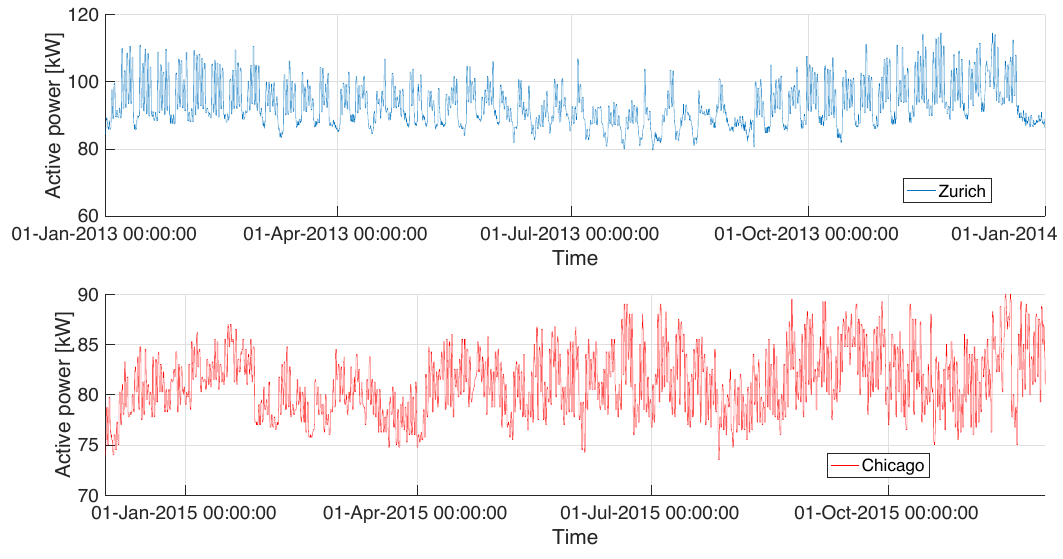
Figure 3. Input data for LSTM training and validation: Zurich and Chicago buildings.